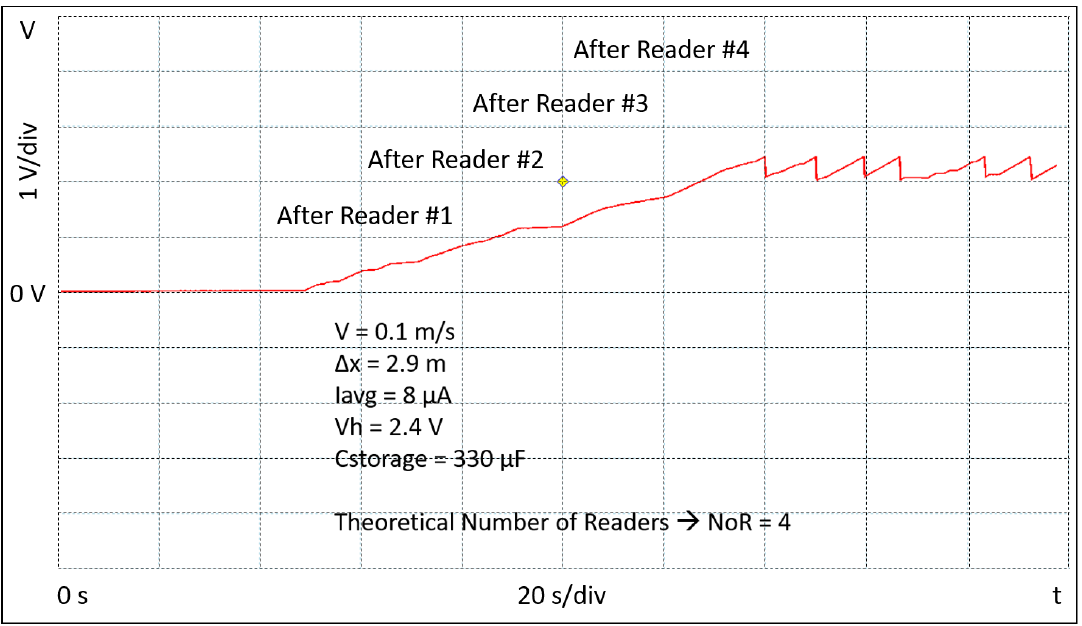
Figure 10. Experimental result of the tag crossing the readers at the speed of 0.1 m/s.